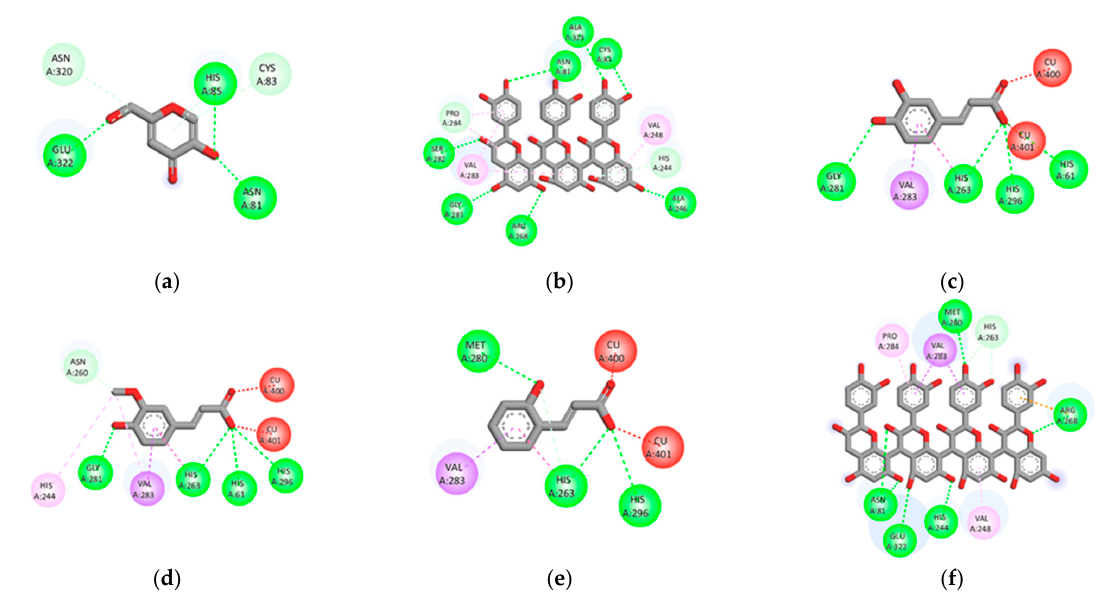
Figure 4. Molecular docking analysis of tyrosinase (2Y9X) is represented by the 2D diagrams of interaction between 2Y9X and positive control and compounds with the lowest binding energy: ( a ) KA (positive control); ( b ) anacardic acid triene; ( c ) caffeic acid; ( d ) ferulic acid; ( e ) o-coumaric acid; ( f ) tetramer of proanthocyanidin.